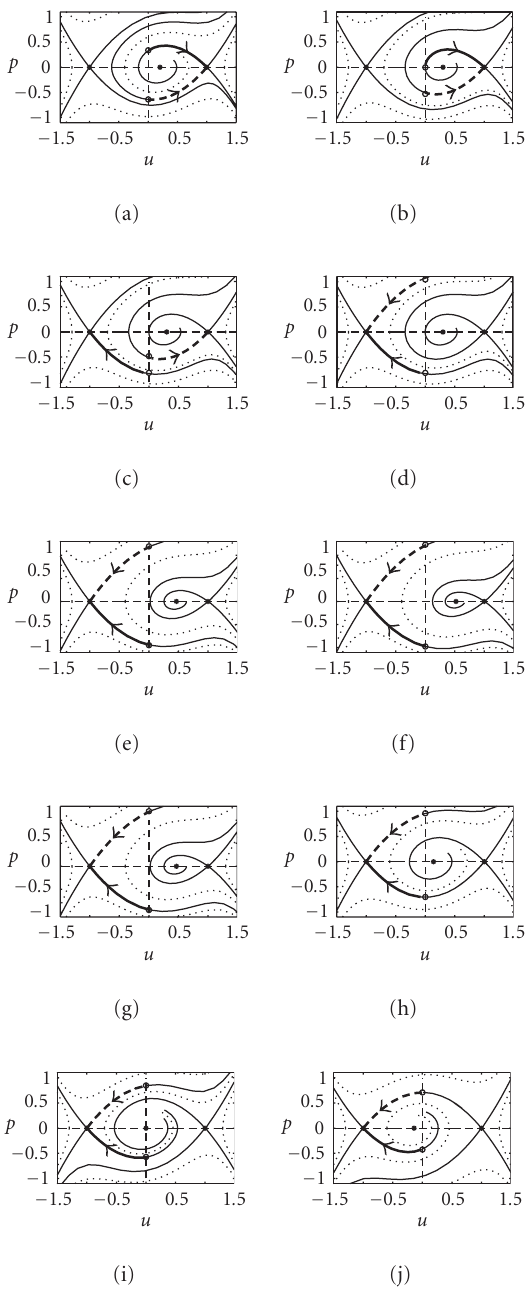
Figure 3.5. Phase portraits illustrating the time dynamics of the boundary layer transitions present near the left (solid line) and the right (dashed line) boundaries of the interval x ∈ [0,1] for a >